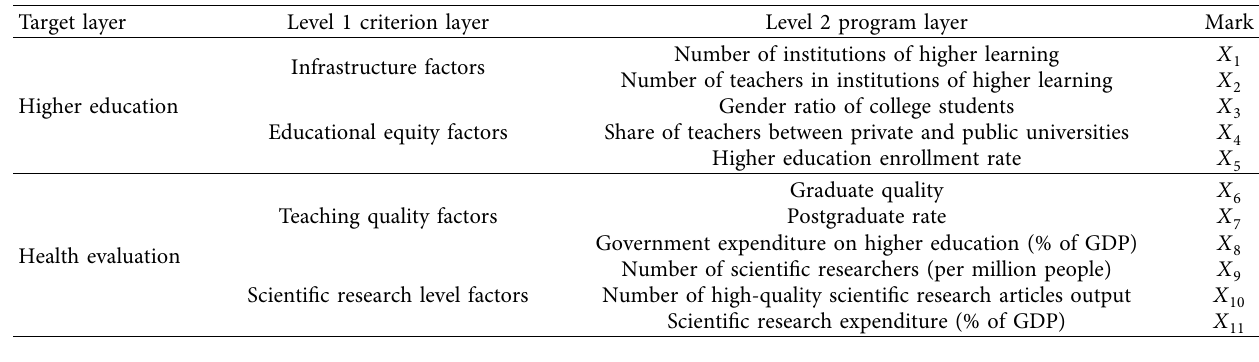
Figure 1: Overall thinking process. Table 1: Hierarchy